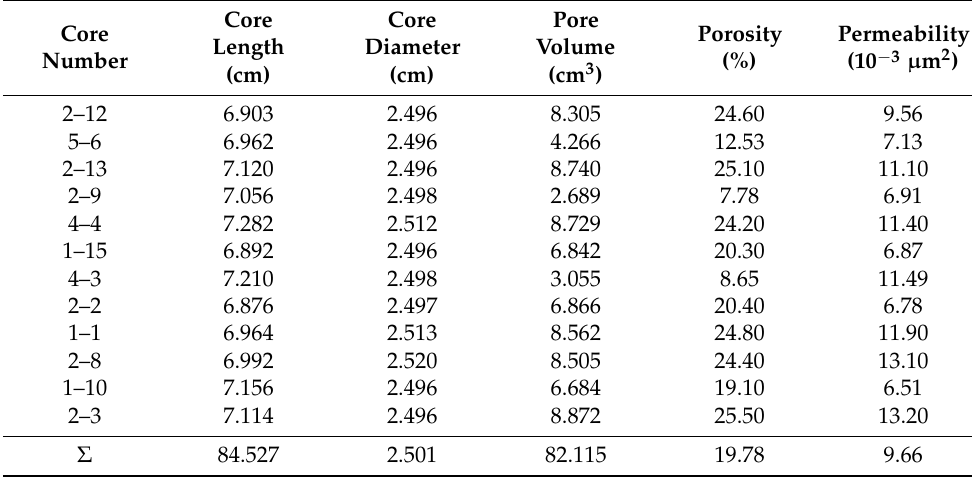
Table 3. Sequence of medium permeability long